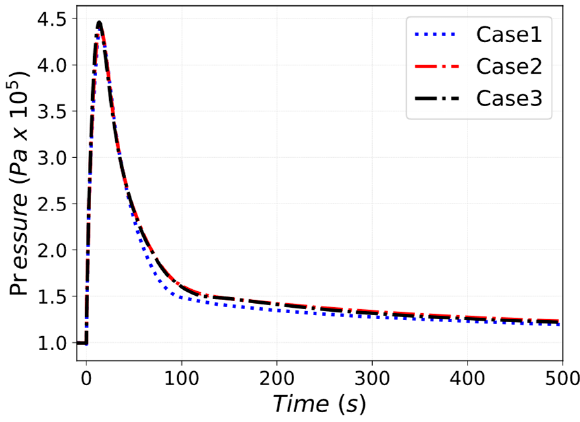
Figure 10. Maximum pressure in UPC, VS and PHTS area.